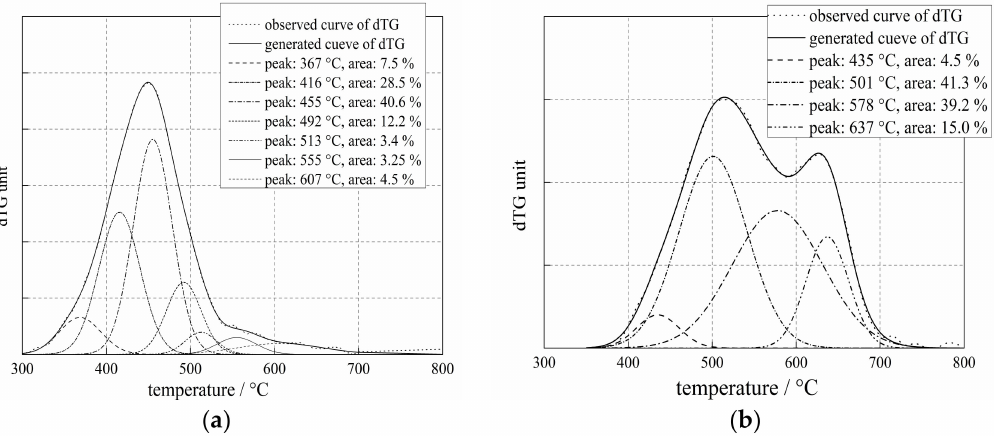
Figure 9. Examples of derivative thermogravimetry (DTG) curves of tv smectites. ( a ) Sample XL_11_NAu1 with 100% of tv layers; ( b ) Sample XL_14_41ValC18 with 85% of tv